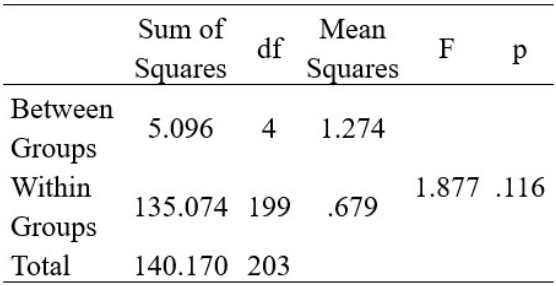
Table 8 . Impact of prospective teachers’